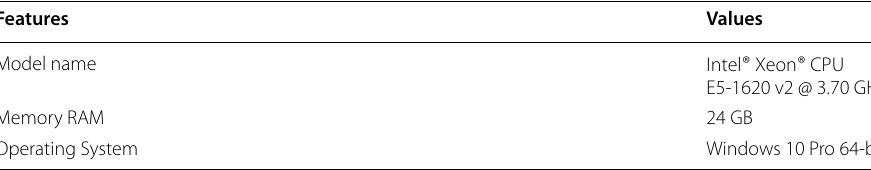
Table 3 Computer used to evaluate the CPU platform